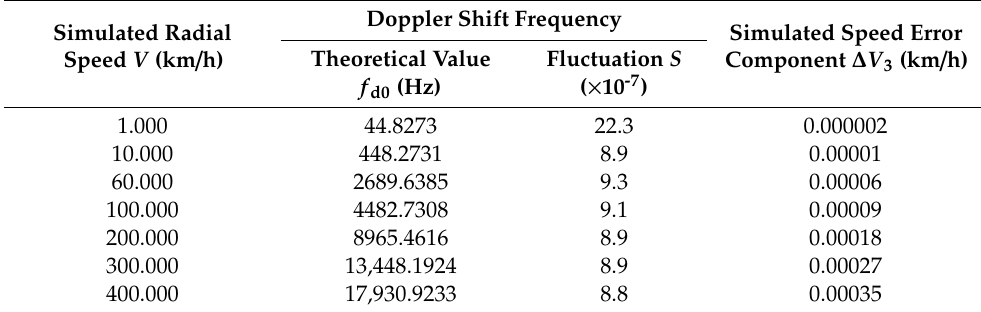
Table 6. Doppler shift frequency fluctuation and simulated speed error component in the fluctuation aspect of the first moving target simulator at emitted frequency of 24,190 MHz.